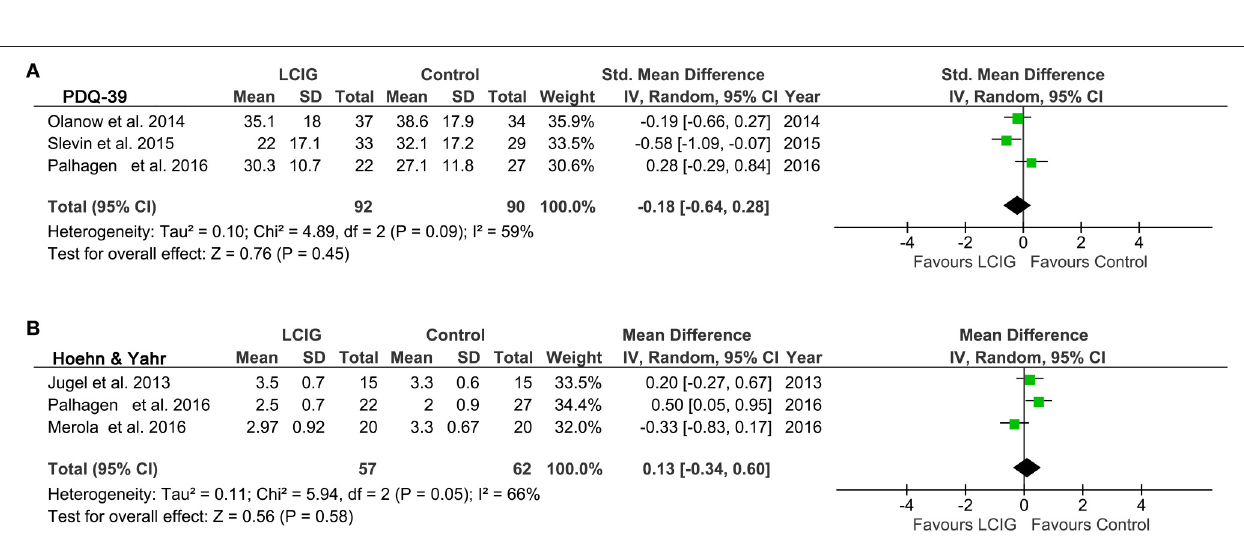
Frontiers in Neurology | www.frontiersin.org